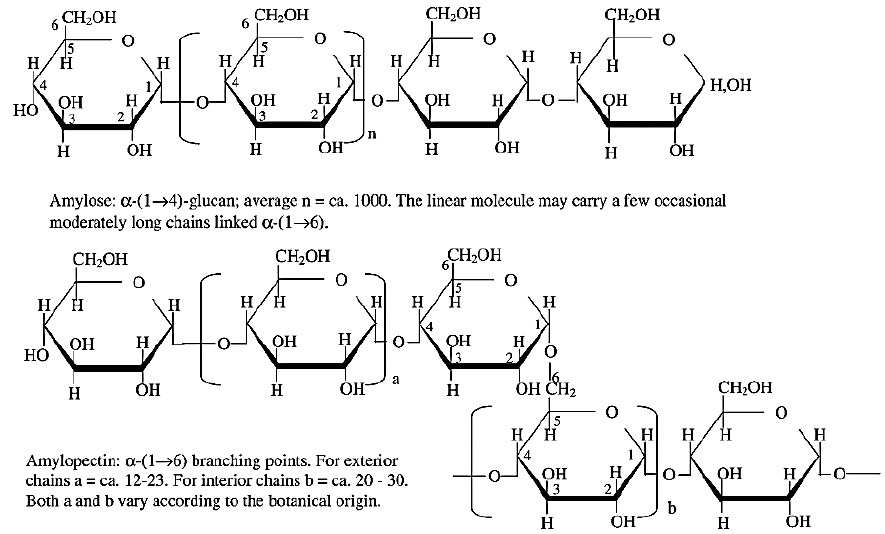
Figure 3. Chemical structure of amylose and amylopectin [66], Reproduced with permission from Elsevier.